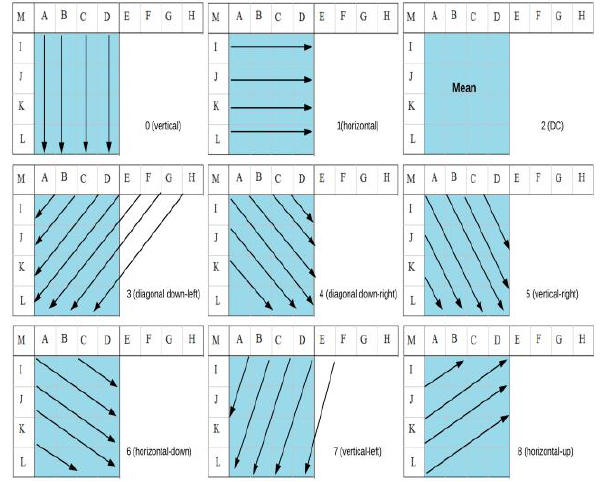
Figure 2. 4x4 intra-prediction modes in H.264.